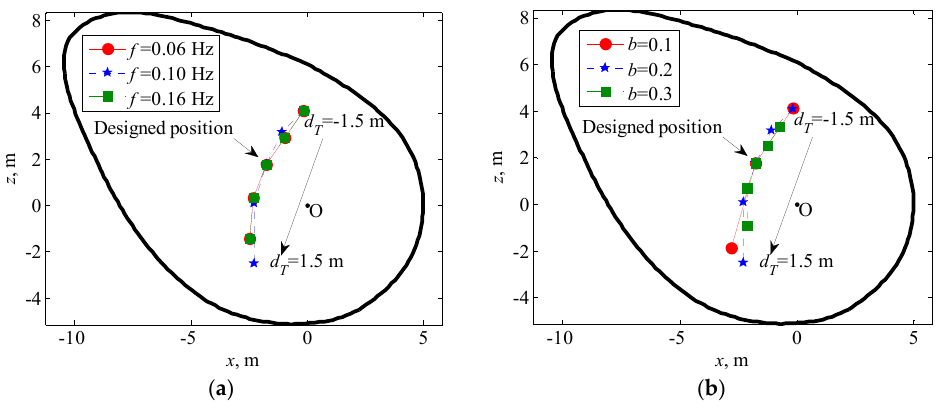
Figure 13. Position of the movable mass variation with tidal height at different wave frequencies and mass ratios: ( a ) for different wave frequencies at L d = 2.5 m, α d = 135°, and b = 0.2; and ( b ) for different mass ratios at L d = 2.5 m, α d = 135°, and f = 0.1 Hz.